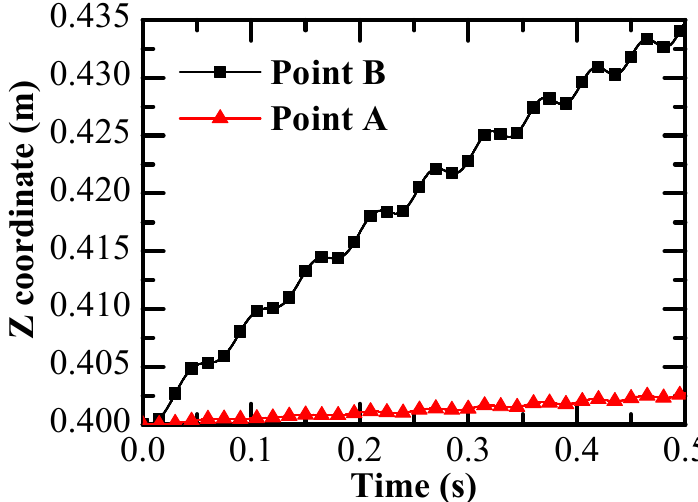
Figure 11. Z coordinate comparison of points A and B.